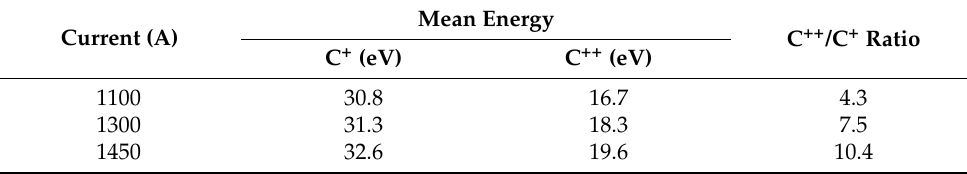
Table 2. Mean energy of single- and double-charged carbon ions at 1100–1450 A arc current. Current